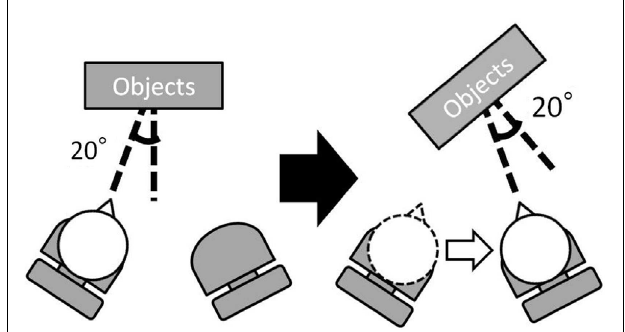
FIGURE 4 | Experimental conditions in Experiment 2. There was only move condition.The viewpoint of the learning phase and that of the transfer phase was 20˚ right from the surface normal of the virtual display. In the transfer phase, the participant and the virtual display moved by the same amount of 40˚ so that the retinal image was the same as in the learning phase.